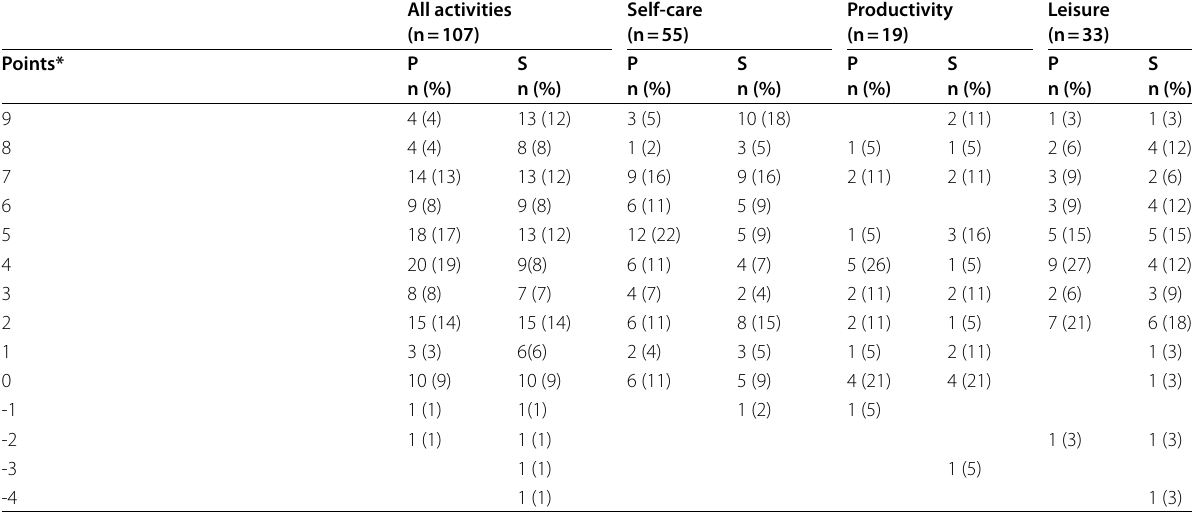
Table 3 Change in the COPM performance (P) and satisfaction (S) scores between baseline and 5 weeks in the identified activities within each of the three areas